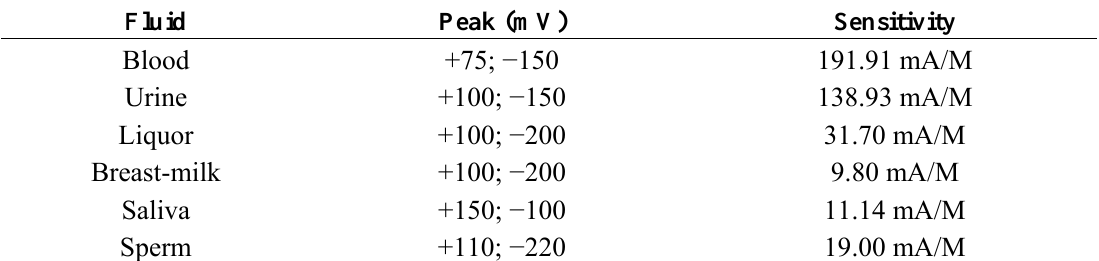
Table 3. Peak potentials and sensitivity of Laccase-based biosensor measured at increasing concentrations in different human biological